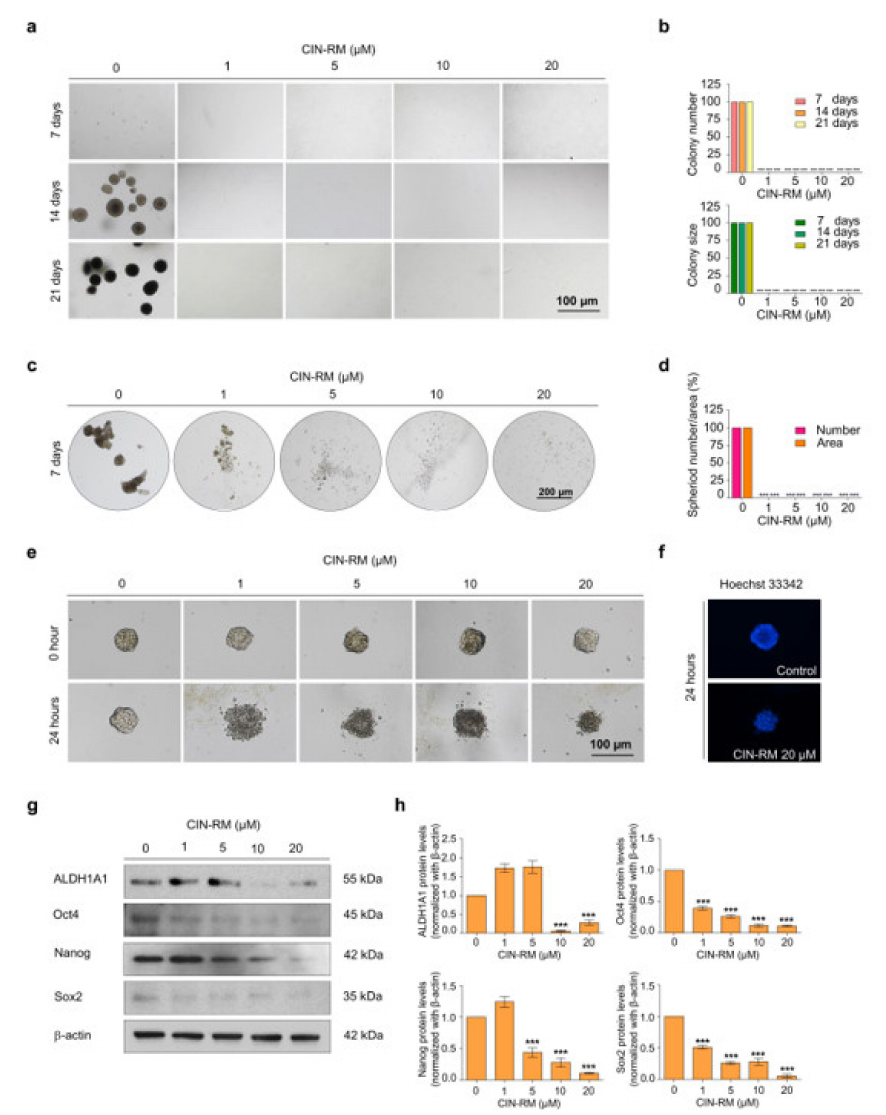
Figure 3. CIN-RM suppresses anchorage-independent growth and cancer stem cell (CSC)-like phenotype of human lung cancer cells. ( a , b ) Cells were pretreated with CIN-RM for 24 h, and the surviving cells were subjected to an anchorage- independent growth assay. ( c , d ) Cells were pretreated with CIN-RM for 24 h and allowed to form primary spheroids for 7 days, and the spheroid of the CSC population was determined. ( e , f ) The CSC single spheroid was treated with toxic concentrations of CIN-RM, and the apoptosis cell death was analyzed with Hoechst 33342. ( g , h ) H460 cells were treated with various concentrations (0–20 µ M) of CIN-RM for 24 h. The expression of ALDH1A1, Oct4, Nanog, and Sox2 were determined by Western blotting. β -actin was determined to confirm equal loading of the samples. Densitometry of each protein was calculated and the results were presented as relative protein levels when compared with untreated control. Data are represented as the mean ± SEM ( n = 3). *** p < 0.001 compared with untreated